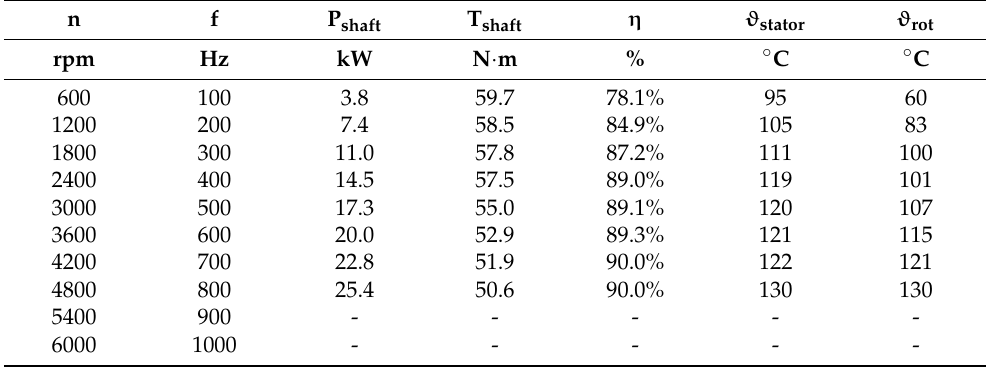
Table 5. The results of tests bench for a model motor with solid rotor S355j2 for the rated load current I N .